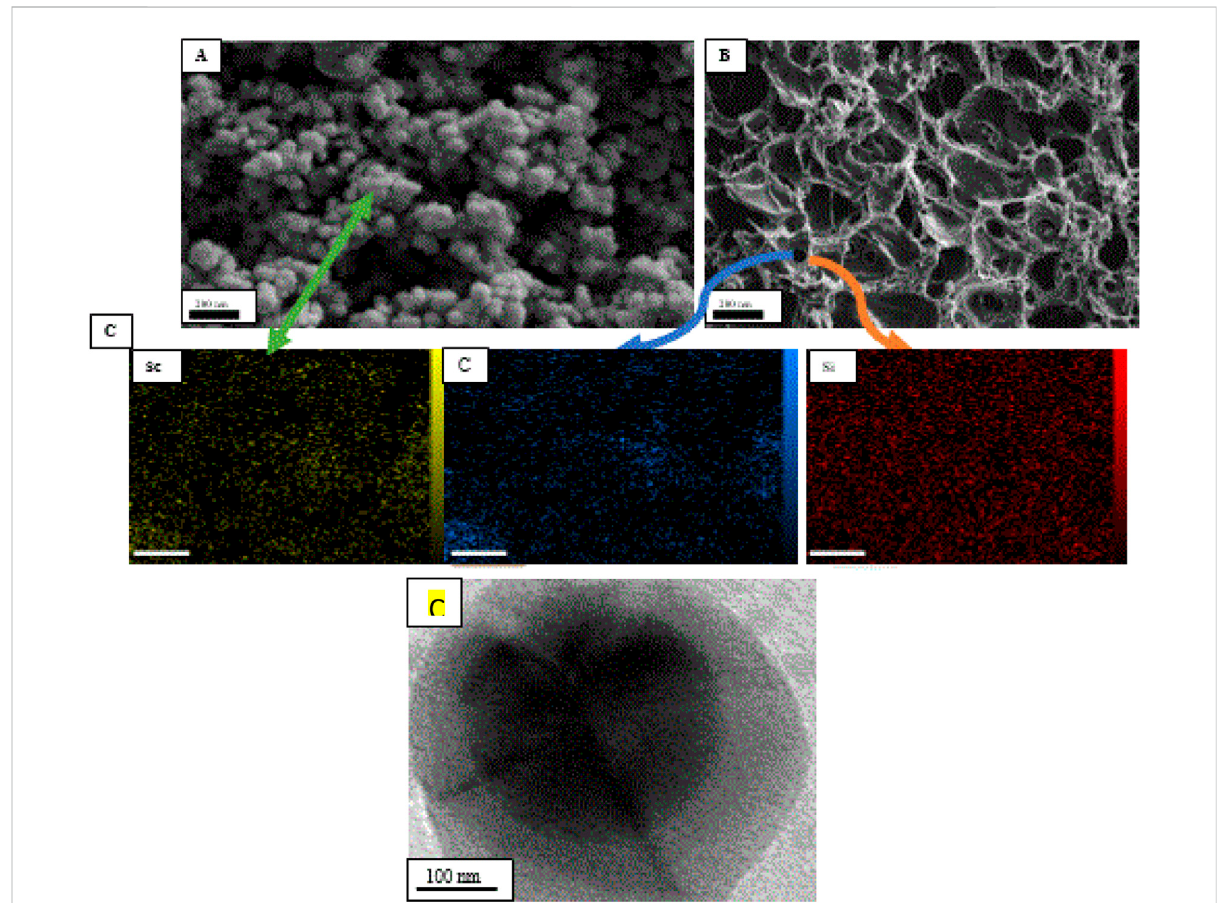
FIGURE 1 SEMimages (A) Sc-MOFand (B) Sc-MOF@SiO 2 )with (C) EDSelementalanalysisforcore(ScandC)andshellstructures(Si)and (D) TEMimageof Sc-MOF@SiO 2 core/shell